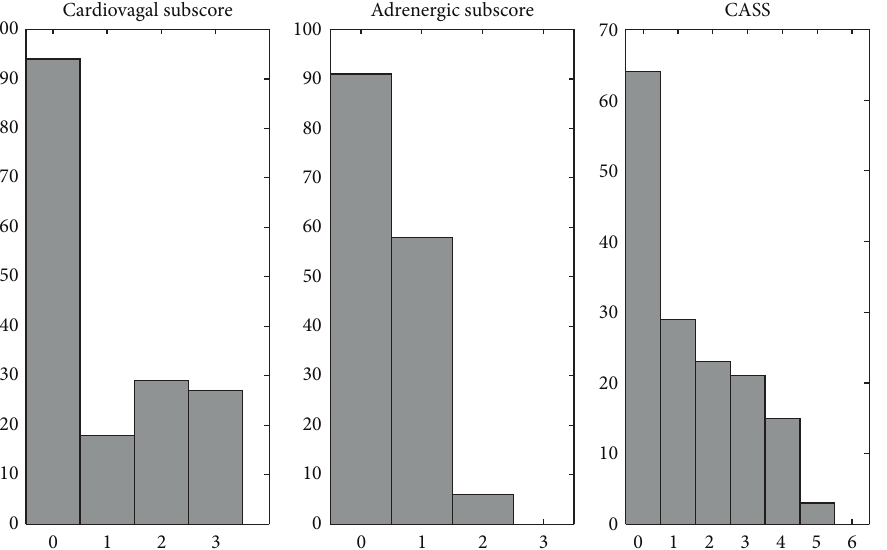
Figure 1: Histograms of cardiovascular autonomic scores, including cardiovagal and adrenergic subscores, and cardiovascular CASS score of the study patients. CASS: Composite Autonomic Scoring